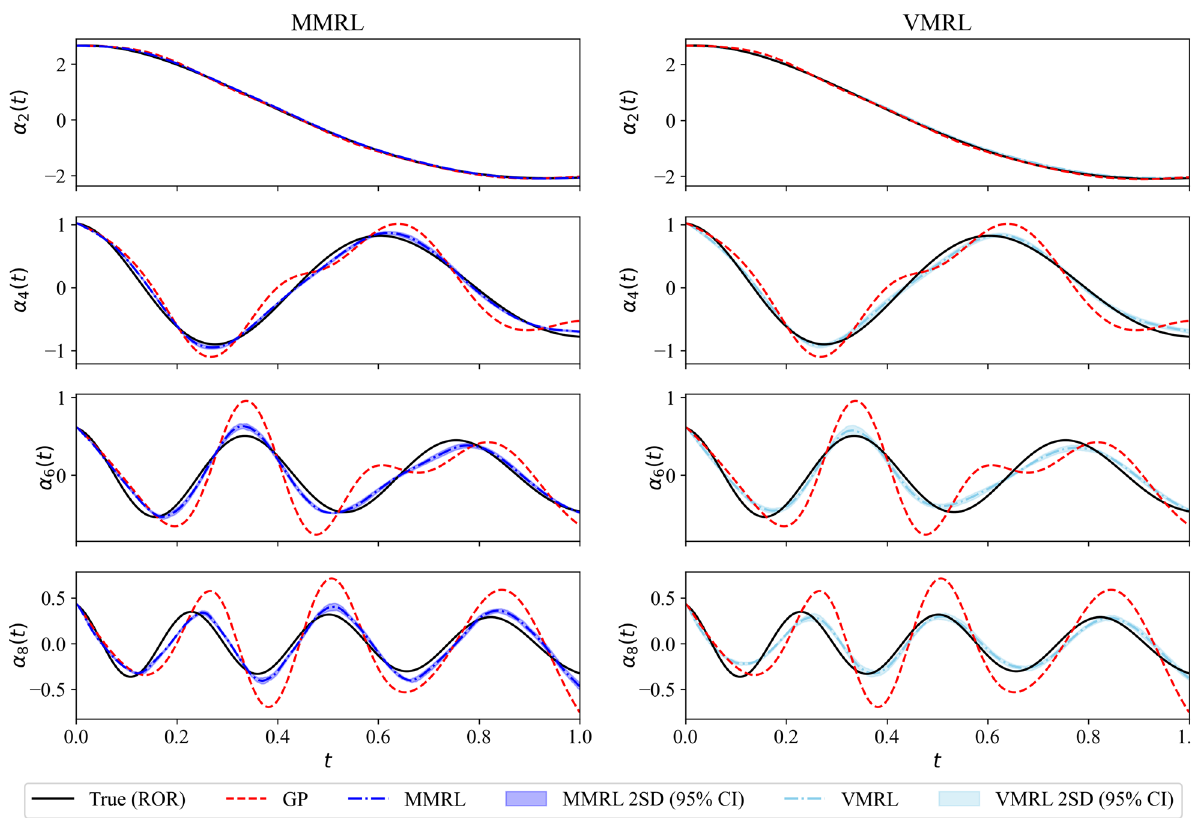
Figure 8. Evolution of the second, fourth, sixth and the last POD modal coefficients at Re = 1500 for MMRL (left) and VMRL (right)